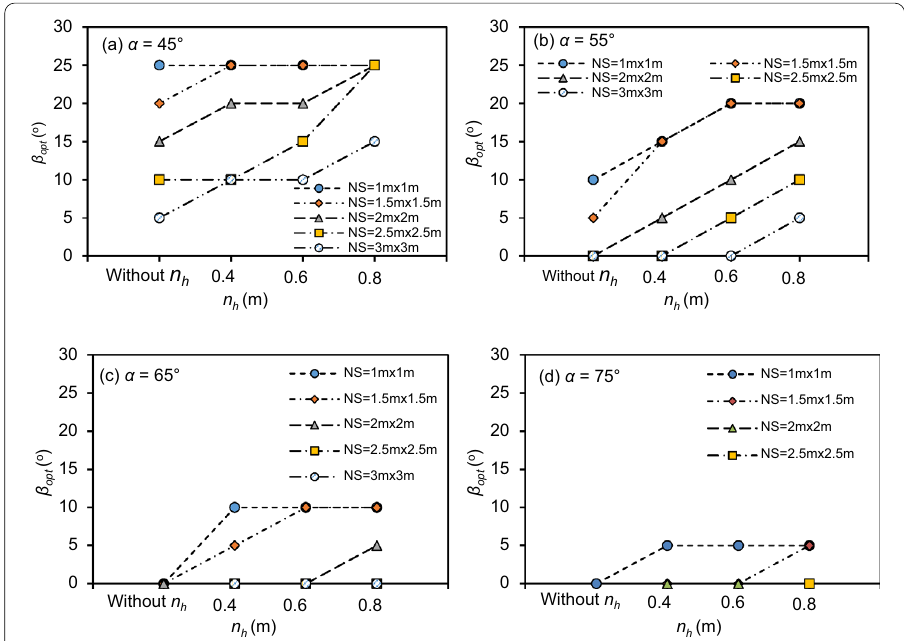
Fig. 9 The effect of nail head size on optimum nail inclination in four different slope angles